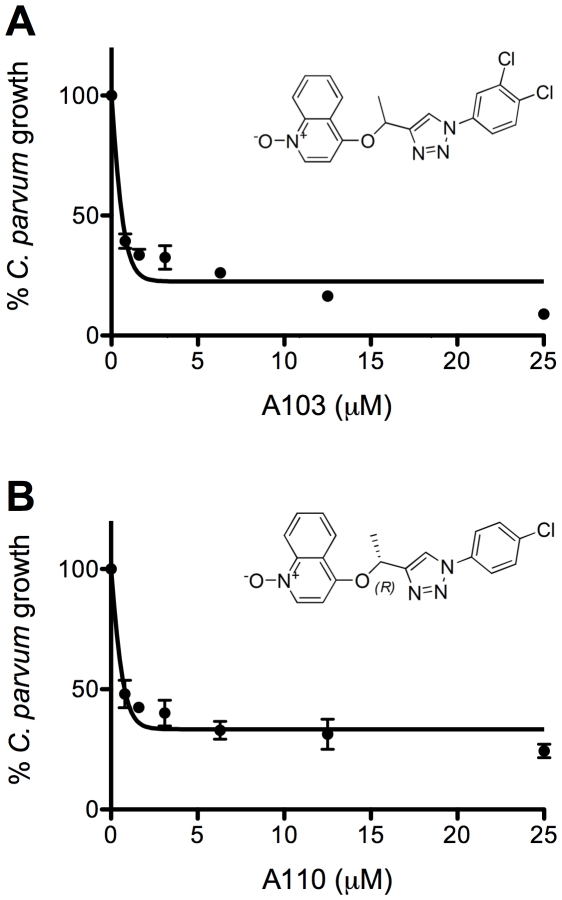
Compounds A103 and A110 are potent inhibitors of C. parvum growth.
C. parvum growth was determined using the HCI assay. The ratio of the number of FITC-VVL labelled C. parvum parasites to DAPI labelled HCT-8 host cell nuclei was used to standardize each well and percent C. parvum growth was normalised to parasites receiving DMSO alone. A and B show compounds A103 and A110 respectively (EC50<0.8 µM). Data shows the mean of two independent experiments with triplicate wells.